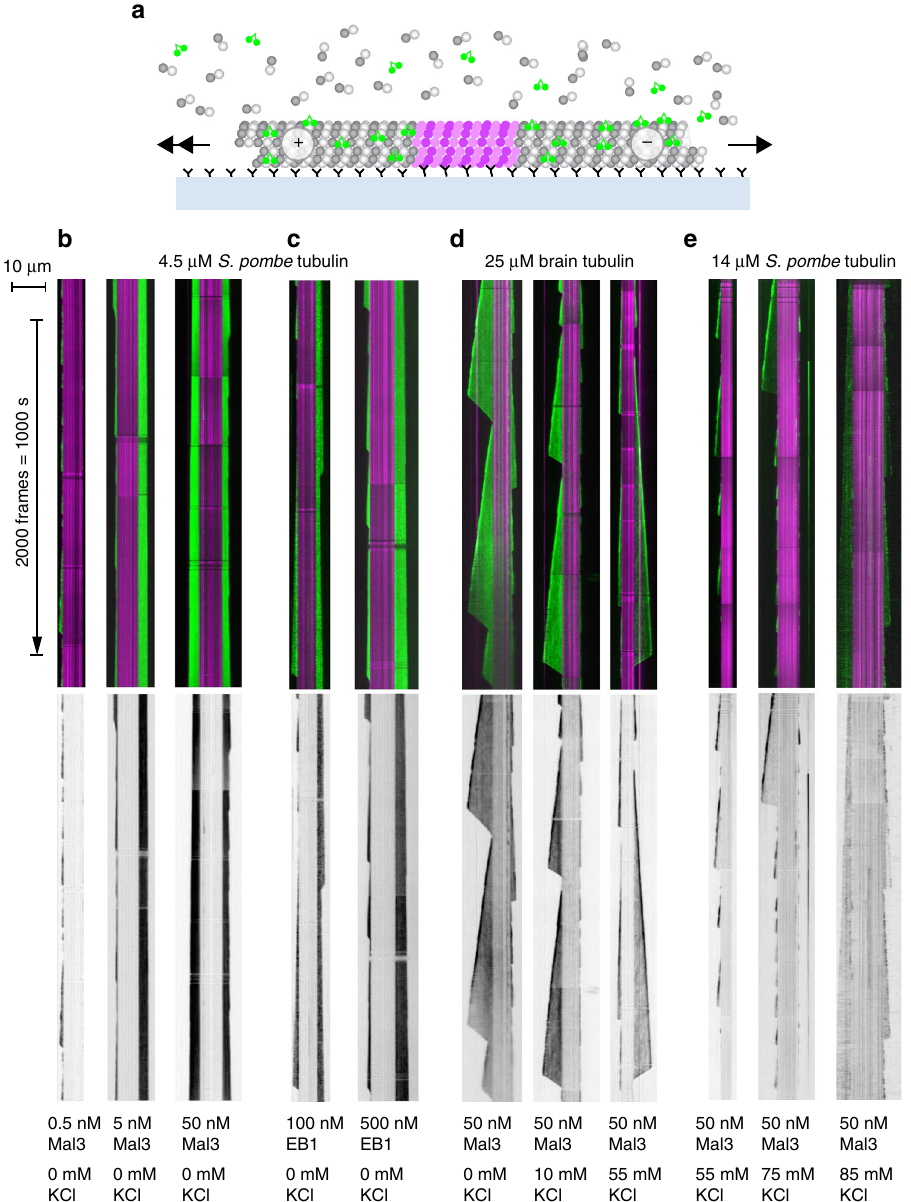
Fig. 7 TIRF microscopy of dynamic MTs + Mal3/EB. a Schematic of experimental setup. Dynamic MTs are grown from stabilized seeds (magenta) linked to the glass surface by anti- fl uorophore antibodies. Binding of EB1-GFP or Mal3-GFP (green) is visualized using TIRF microscopy. b – e Kymographs showing the pattern of Mal3-GFP binding or EB1-GFP binding (green) to dynamic, unlabeled Sp_tub MTs or Mam_tub MTs. Depending on the buffer conditions and protein concentrations, differential binding to tip and lattice (tip-tracking) is or is not apparent. b Mal3-GFP binding (green) to dynamic, unlabeled Sp_tub MTs grown at 4.5 µ M Sp_tub concentration from antibody-immobilized, Alexa-488-labeled GMPCPP-Mam_tub seeds (magenta). Buffer is PEM100 plus 1 mM GTP. Greyscale kymograph shows the Mal3-GFP channel only. Under these conditions, Mal3-GFP binds uniformly to the lattice, without obviously favouring the MT tips. c Kymographs showing the pattern of EB1-GFP binding (green) to dynamic, unlabeled Sp_tub MTs grown at 4.5 µ M tubulin concentration from antibody-immobilized, Alexa488-labeled GMPCPP-Mam_tub seeds (magenta). Greyscale kymograph shows the EB1-GFP channel only. Buffer is PEM100 (see Methods section) plus 1 mM GTP. Under these conditions also, EB1-GFP binds uniformly to the tips and the lattice. d Kymographs showing the pattern of Mal3-GFP binding (green) to dynamic, unlabeled Mam_tub (pig brain) MTs grown at 25 µ M tubulin concentration from antibody- immobilized GMPCPP-Mam_tub seeds (magenta). Greyscale kymograph shows the Mal3-GFP channel only. Buffer is PEM100 plus 1 mM GTP plus additional KCl as indicated. Under these conditions, Mal3-GFP enriches at growing plus ends. Raising the KCL concentration depopulates the lattice more than the tips. e Kymographs showing the pattern of Mal3-GFP binding (green) to dynamic, unlabeled Sp_tub MTs grown at 14 µ M tubulin concentration from antibody-immobilized GMPCPP-Mam_tub seeds (magenta). Greyscale kymograph shows the Mal3-GFP channel only. Buffer is PEM100 plus 1 mM GTP plus additional KCl as indicated. Mal3-GFP enriches at growing plus ends. Under these conditions, plus end assembly is frequently interrupted